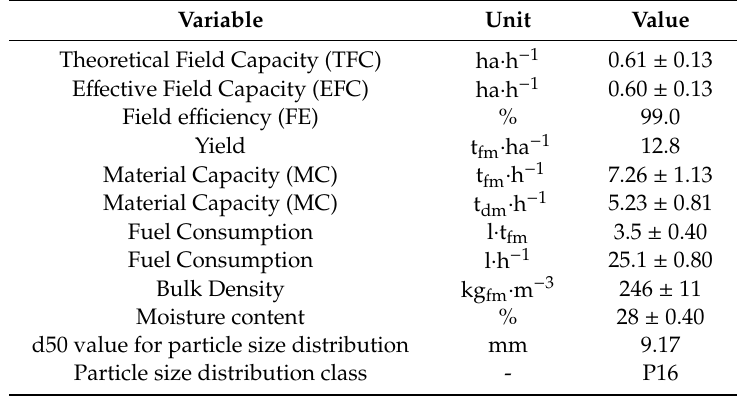
Table 2. Results of the performance and work quality of the stationary harvesting Caravaggio mod. BIO